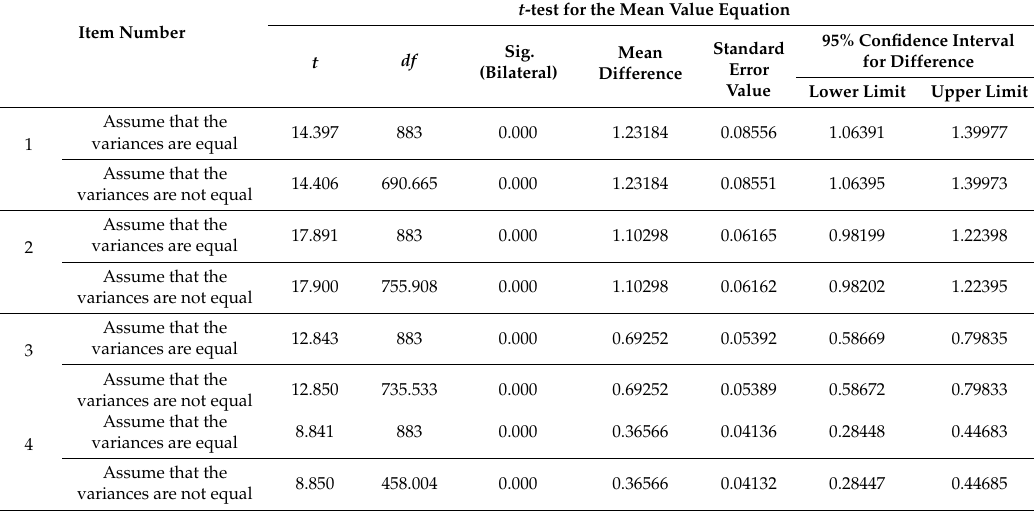
Table A1. Independent sample t -test